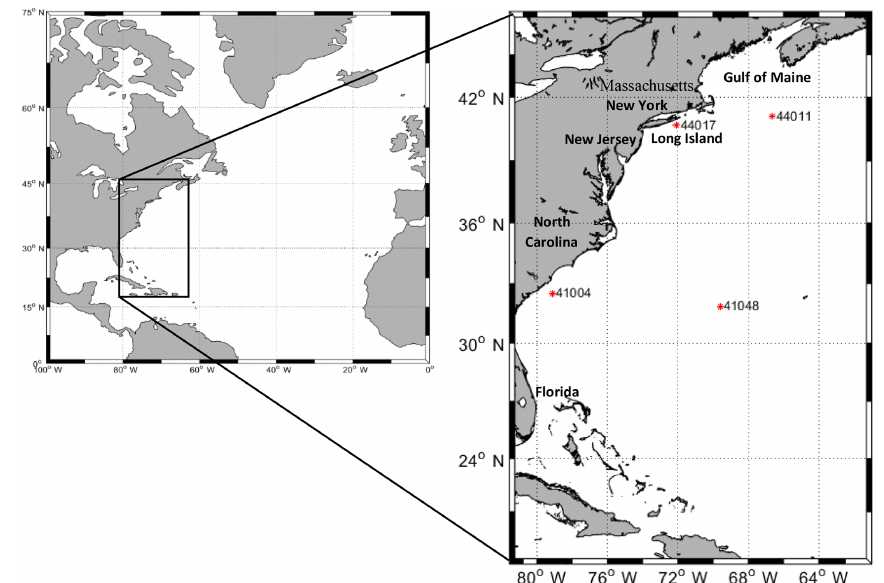
Table 1. Information on NDBC stations used for evaluation of model results. Buoy Depth (m) Description Longitude Latitude 41004 38.4 EDISTO – 41nmi southeast of Charleston, SC − 79 . 099 32.501 41048 5340 WEST BERMUDA – 240nmi west of Bermuda − 69 . 590 31.86 44011 82.9 − 66 . 619 41.098 44017 52.4 − 72 . 048